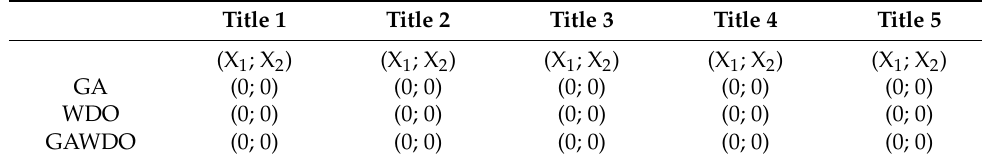
Table 3. Algorithm results on the Ackley